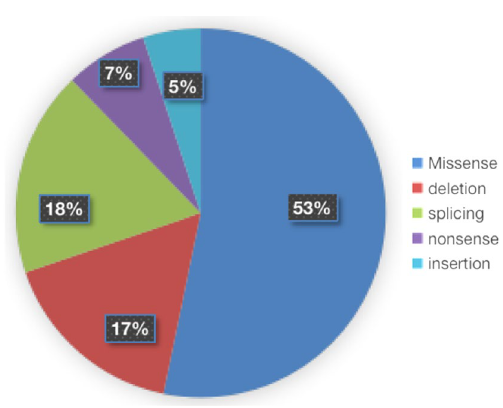
Figure 8. Proportions of FRMD7 mutation types identified in this study and reported